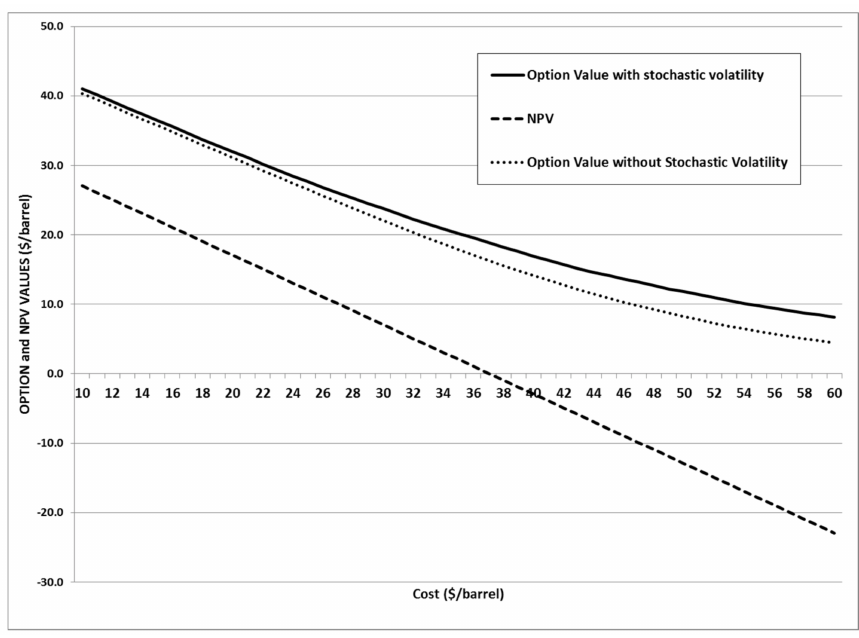
Figure 5. Value of the option to delay with and without stochastic volatility.